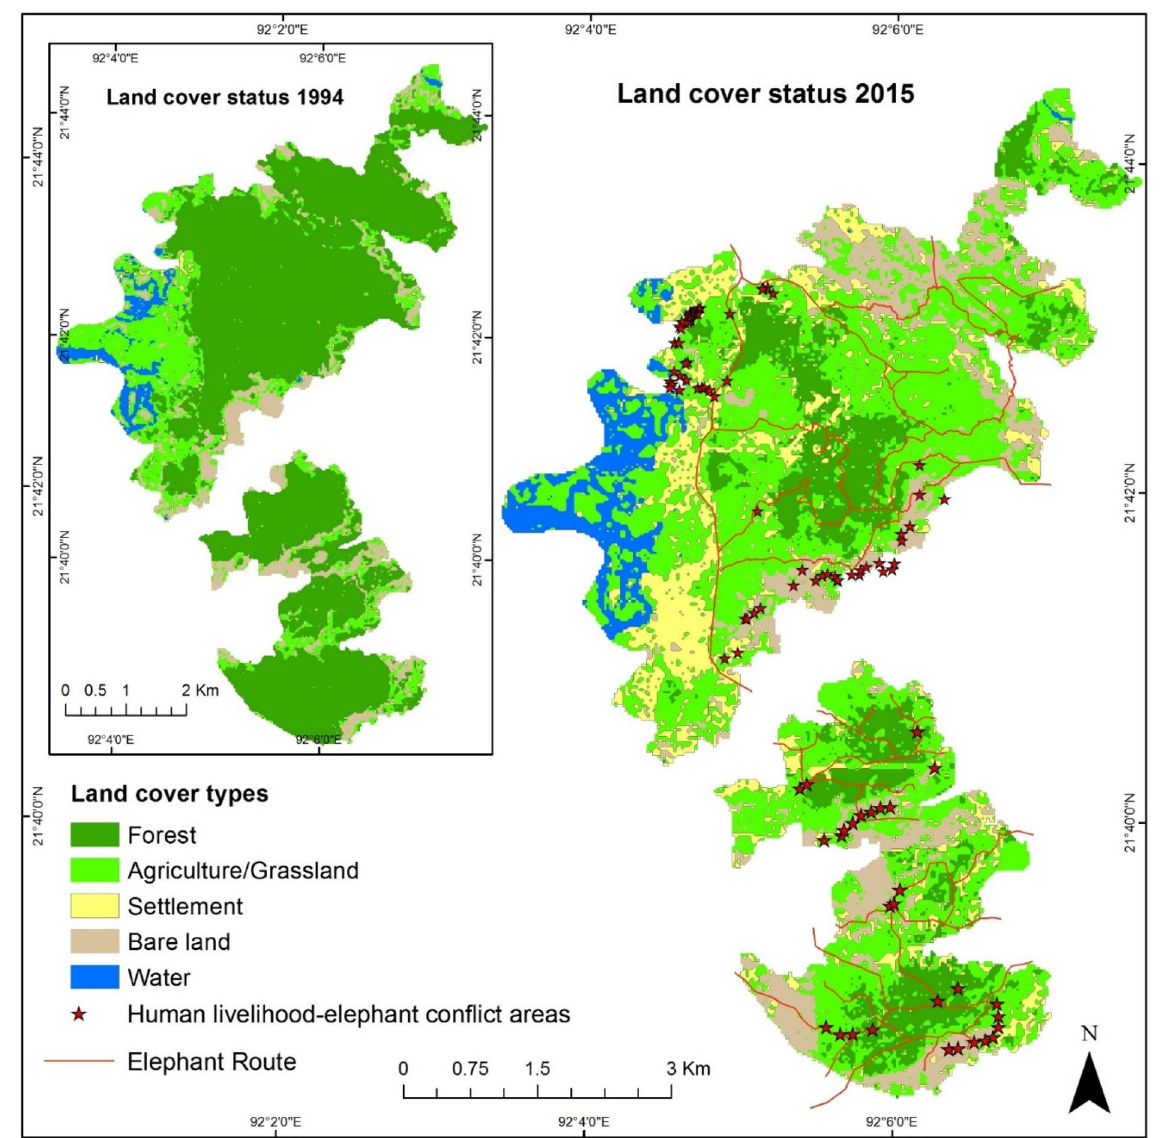
Fig. 5 Wild elephant